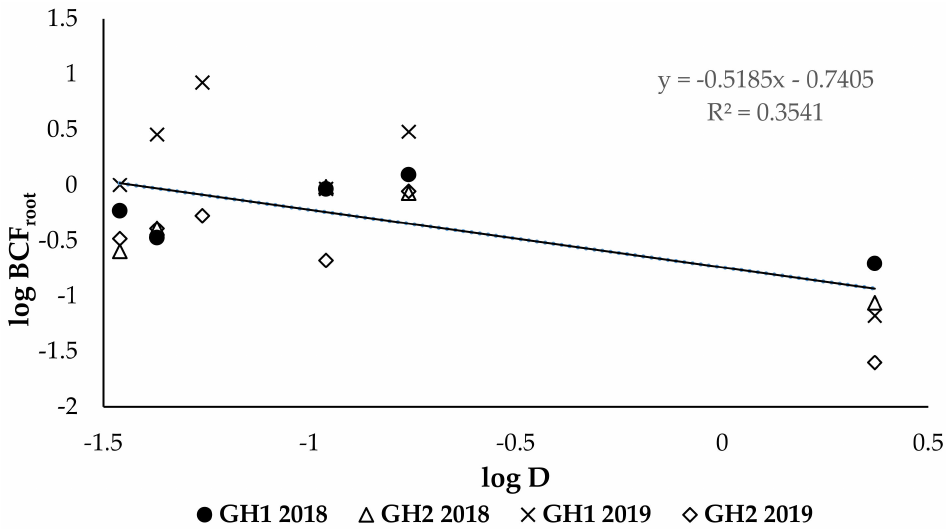
Figure 3. Correlation between log BCF and logD of target sulfonamides in soils and RWW in